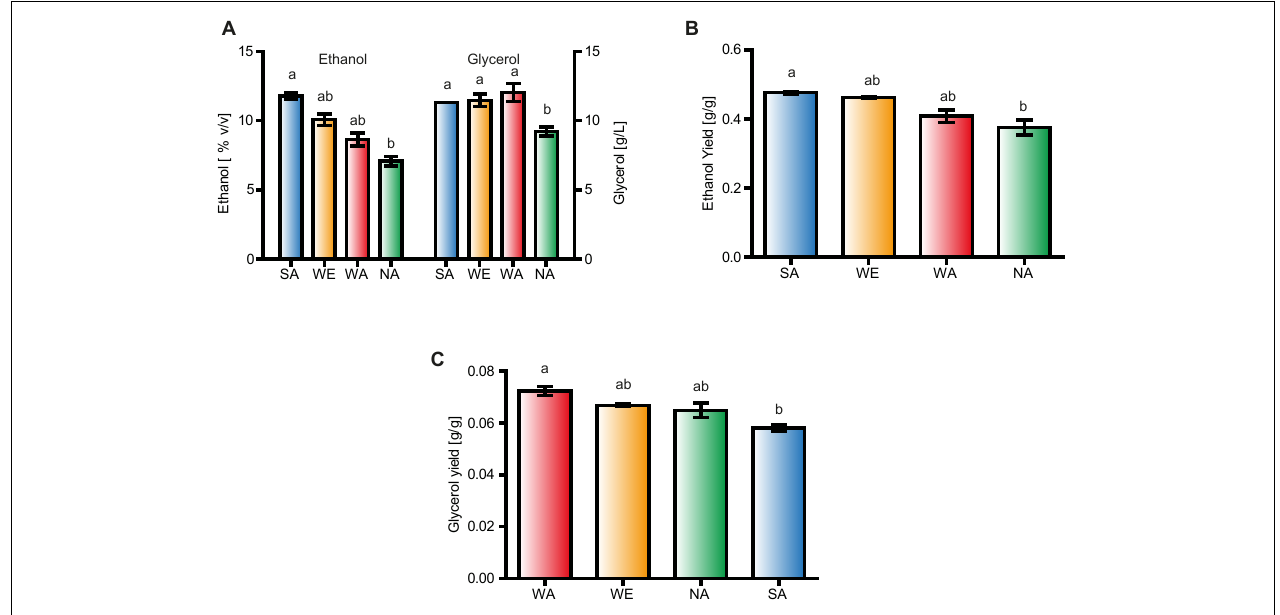
FIGURE 1 | Glycerol production in S. cerevisiae strains. (A) Glycerol and ethanol levels; (B) Ethanol yield and (C) glycerol yield in Sake (SA), West African (WA), Wine/European (WE), and NA (North American strains) after fermentation in synthetic wine must. Different letters indicate significant differences between genotypes.